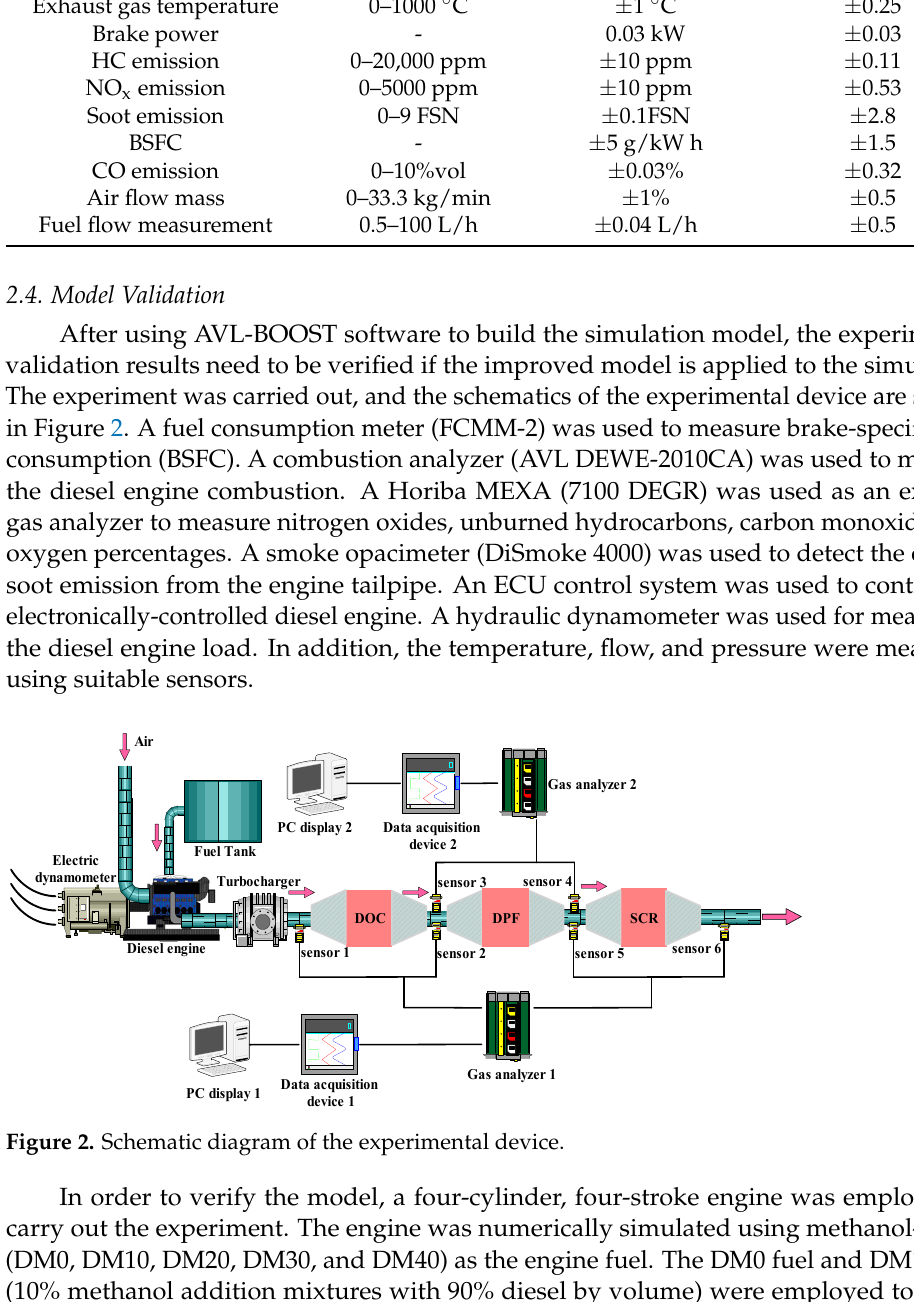
Figure 3. Comparison of cylinder pressure and HRR under different fuel mixing ratios. 3. Results and Discussion The simulation experiment was carried out at the speed of 1000–4000 rpm. The ef- fects of different ratios of methanol-diesel mixtures on engine performance and emission characteristics were studied in terms of cylinder pressure, cylinder temperature, brake-specific fuel consumption (BSFC), brake power, brake thermal efficiency (BTE), soot emission, NO x emission, CO emission, HC emission, and so on. In addition, the ac- tual air-fuel ratio of pure diesel (DM0) was 14.355, that of 90% diesel and 10% methanol (DM10) was 13.755, that of 80% diesel and 20% methanol (DM20) was 12.941, that of 70% diesel and 30% methanol (DM30) was 12.127, and that of 60% diesel and 40% methanol (DM40) was 11.313.